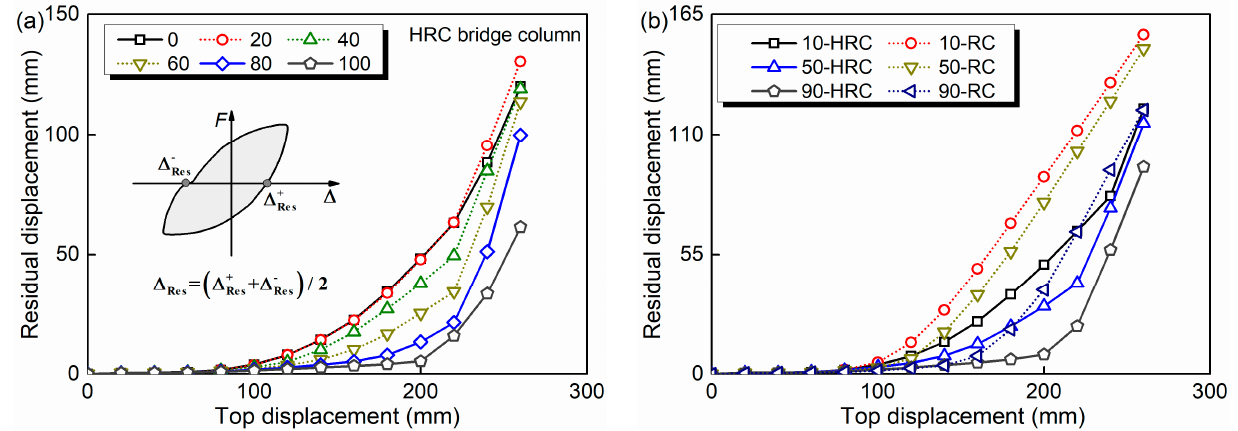
Figure 9. Time-dependent residual displacements of: ( a ) HRC bridge column; ( b ) HRC and RC bridge column.